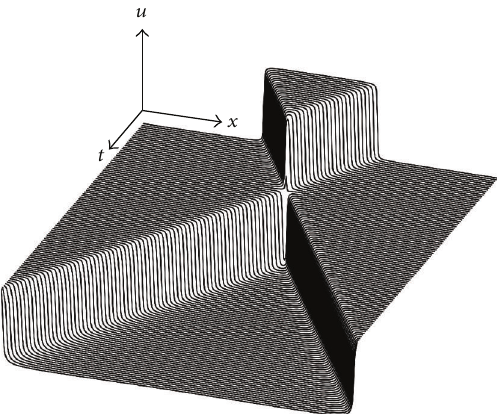
Figure 2: Evolution of the kink-antikink pair, 𝑉 1 > 0 , 𝑉 2 < 0